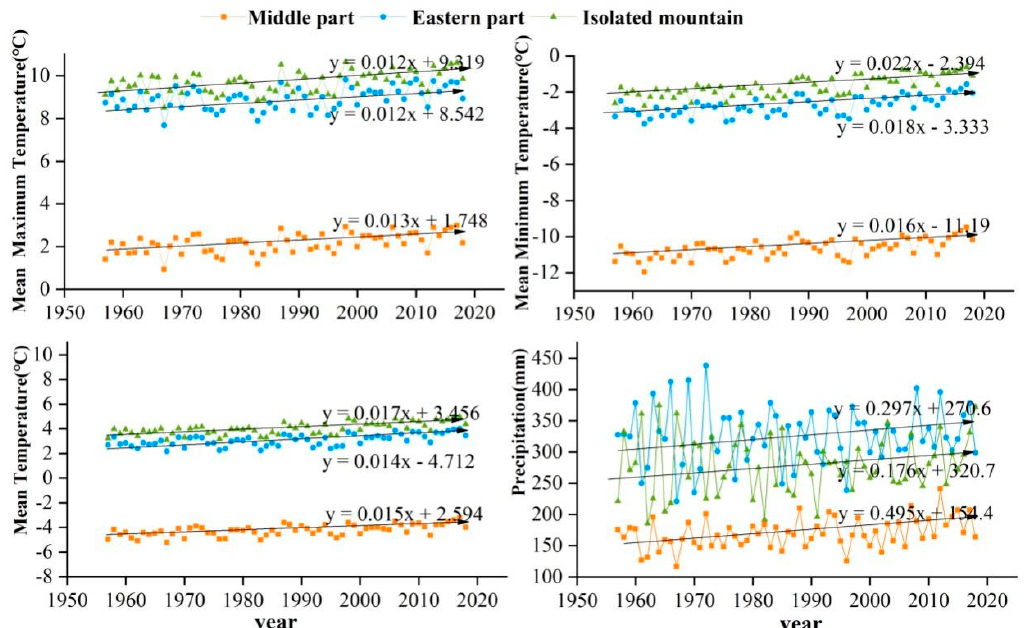
Figure 2. Interannual variabilities of the mean maximum, mean minimum, mean temperatures, and total precipitation for 1957–2018 in three Central and Eastern Qilian Mountains regions.